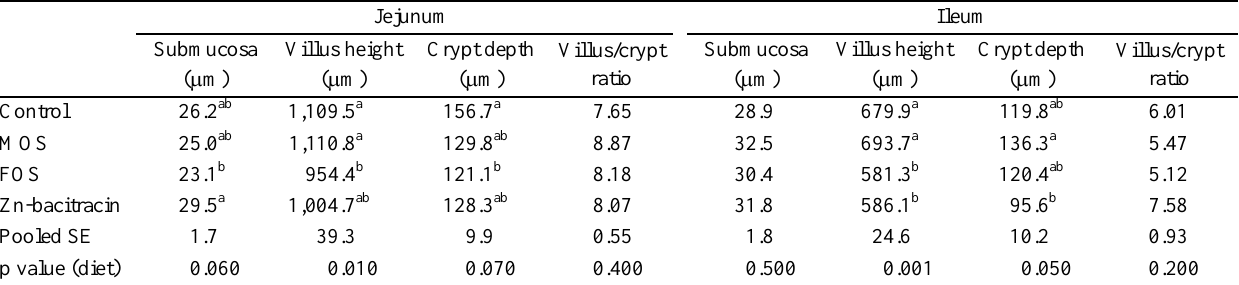
Table 6. Effects of oligosaccharides and antibiotic supplementation on histological development of jejunum ileum at 28 d of age (n = 12) Jejunum